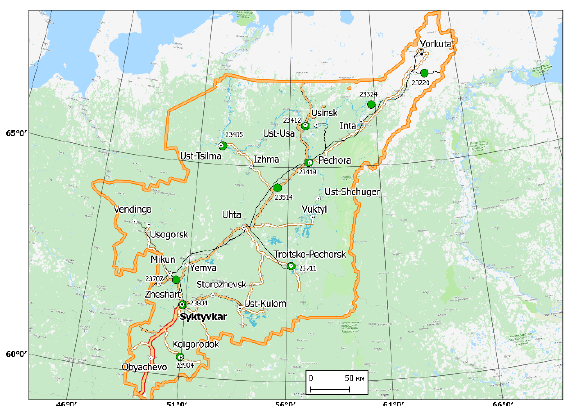
Figure 3. Meteorological stations (green points) of the Komi